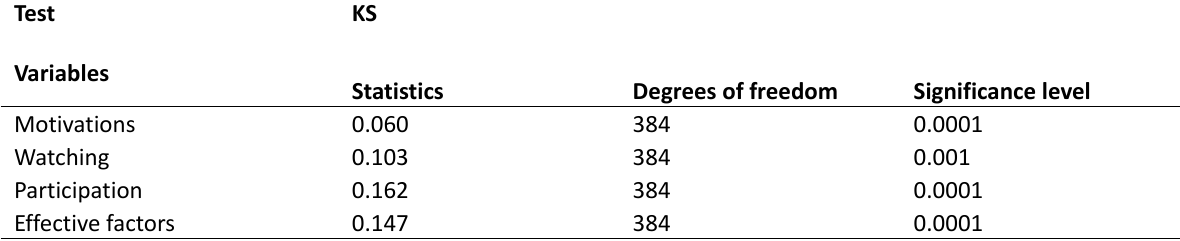
Table 2. Test of normality for the distribution of the